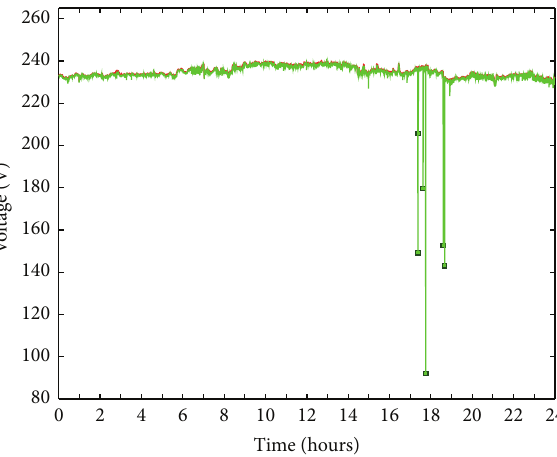
Figure 2: Voltage values registered during one day in the first facility. The green line represents the minimum voltages, where the green big dots are the voltage dips, the black line represents the